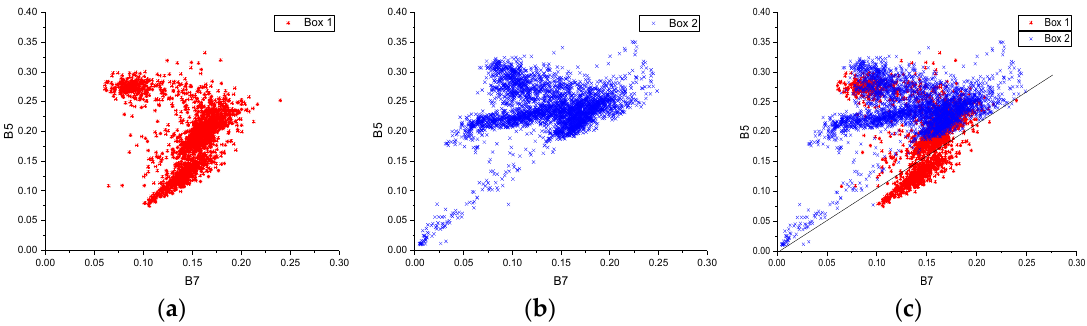
Figure 5. Relationship between the reflectance at MODIS band 5 (1.24 µ m) and the reflectance at MODIS band 7 (2.13 µ m) of the samples extracted in Range 12 Fire: ( a ) scatter plot of samples in Box 1; ( b ) scatter plot of samples in Box 2; ( c ) Combined scatter plot of (a) and (b). Table 5. Empirical formula and coefficients α and β of the three wildfire cases. Empirical Formula Coefficient Hot Pot